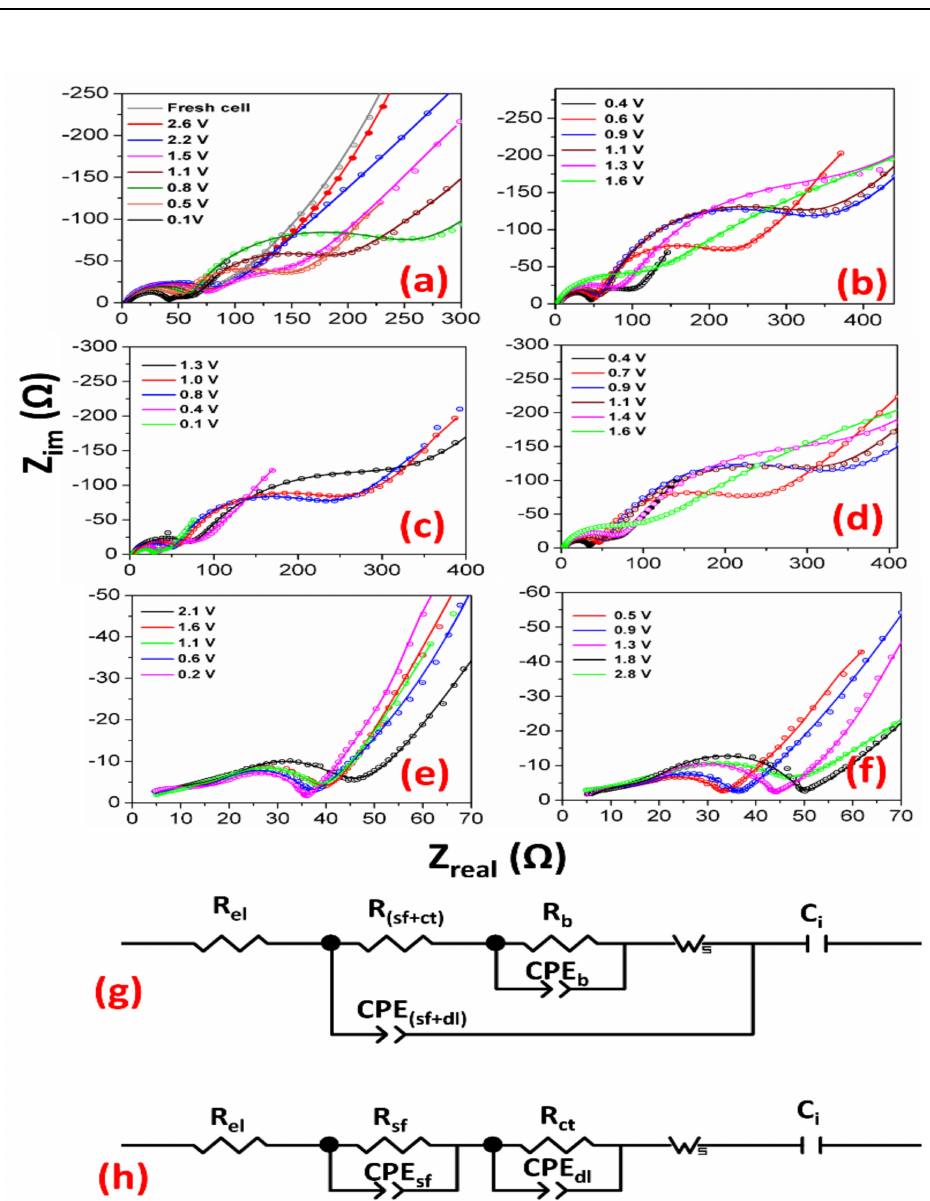
Figure 5. EIS spectra (Nyquist plots) of G-NiFum at various voltages during ( a ) 1st discharge cycle, ( b ) 1st charge cycle, ( c ) 2nd discharge cycle, ( d ) 2nd charge cycle, ( e ) 200th discharge cycle, ( f ) 201st charge cycle, and ( g , h ) equivalent circuits used for fitting the experimental Nyquist